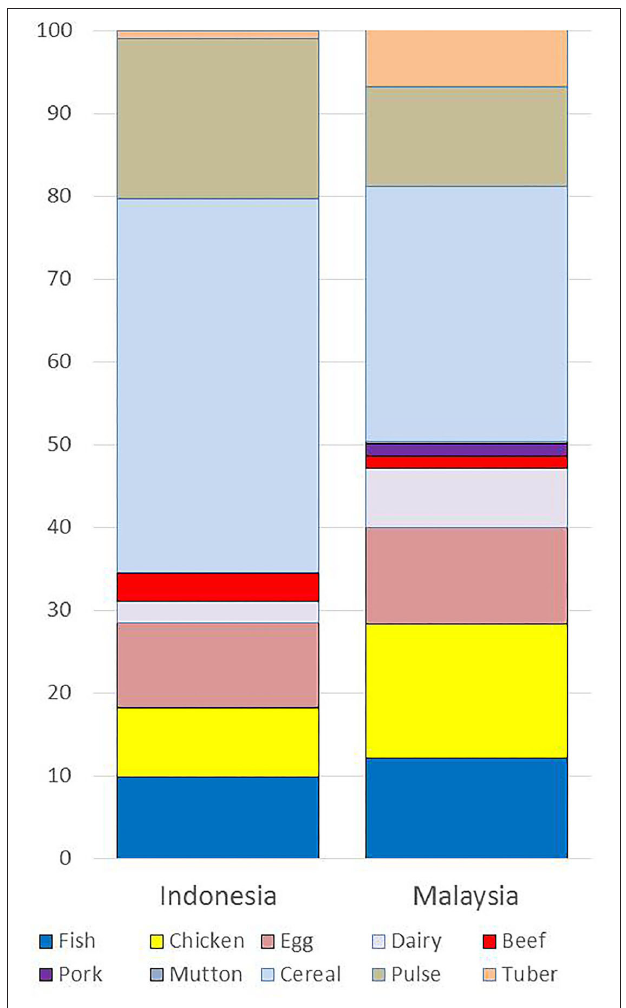
FIGURE 1 | Percent frequencies of protein consumption by food source for Indonesia and Malaysia. Data for full samples: Indonesia N = 1,665 and Malaysia N = 1,604. Malaysia data based on Drewnowski et al. (